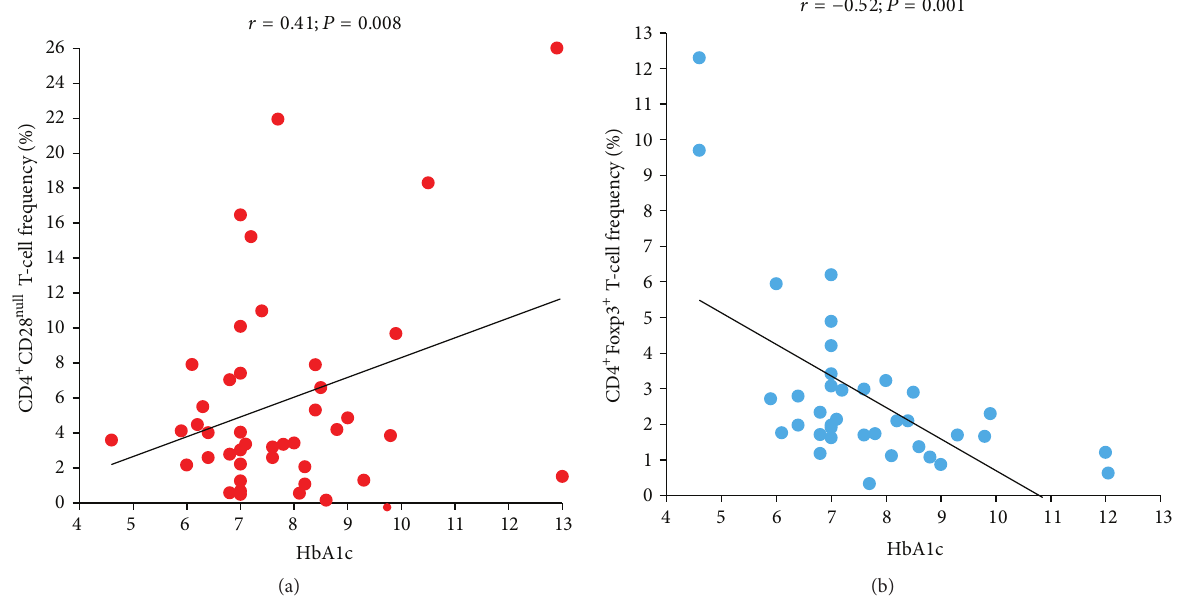
Figure 6: Correlation between T-cell subsets and serum HbA1c levels in T2DM patients. T2DM patients were defined as in Figure 1. Data are presented as single data points. (a) CD4 + CD28 null T-cell frequency positively correlates with HbA1c in T2DM patients. (b) CD4 + FoxP3 + T-cell negatively correlates with HbA1c in T2DM